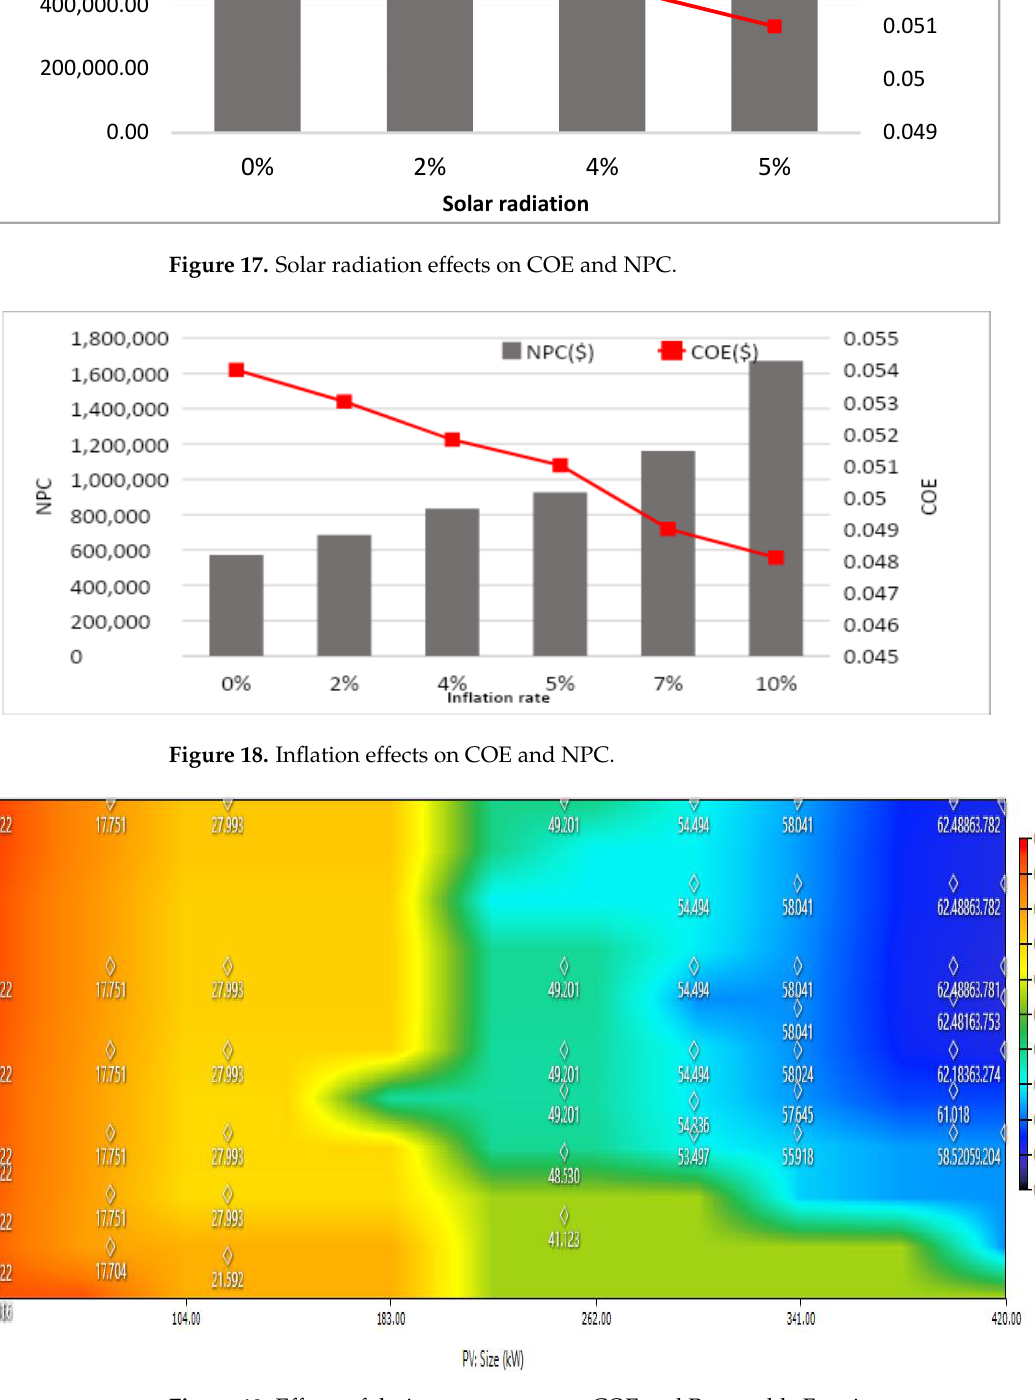
Figure 17. Solar radiation effects on COE and NPC.